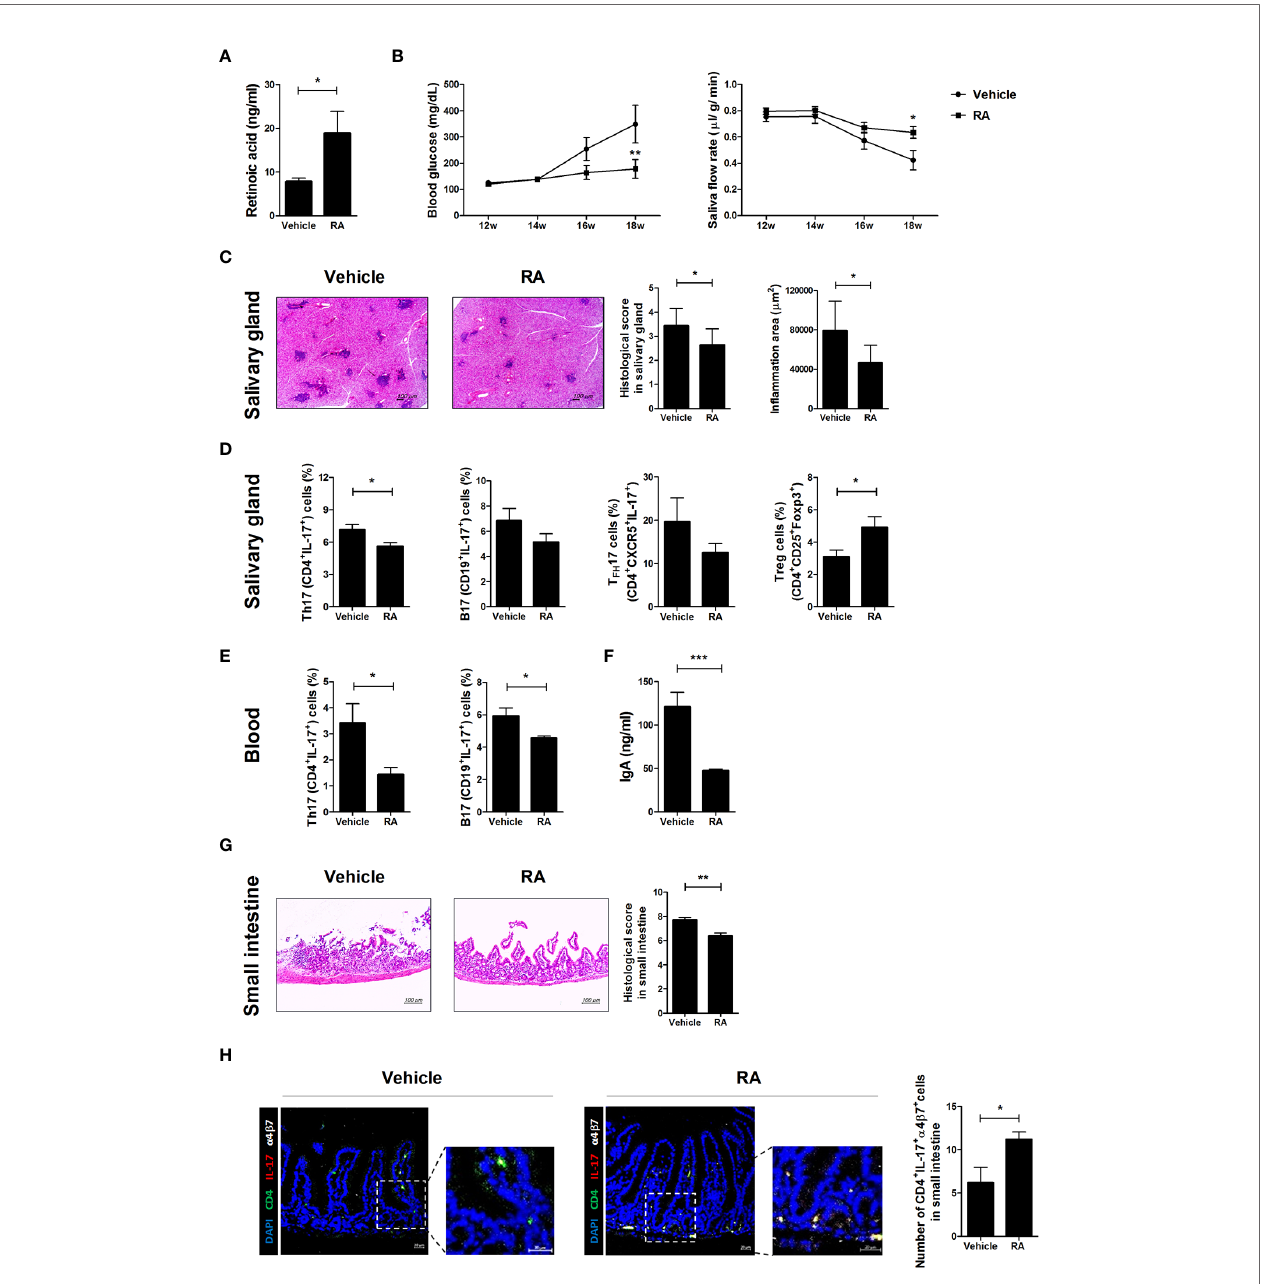
FIGURE 5 | Treatment with RA ameliorated SS symptoms in NOD/ShiLtJ mice. We injected 12-week-old NOD/ShiLtJ mice intraperitoneally with 1 mg/kg RA three times per week for 6 weeks. (A) Bar graph shows average RA levels in sera from vehicle- (N=5) and RA-treated mice (N=5). (B) Blood glucose levels (left) and salivary fl ow rates (right) were measured in vehicle- (N=10) and RA treated-NOD/ShiLtJ mice (N=10) at the indicated ages. (C) Representative H&E-stained images of salivary glands from vehicle- (left) (N=10) and RA treated- (right) NOD/ShiLtJ mice (N=10). Bar graph shows average in fl ammation area of salivary glands. Scale bar= 100 µm. (D) Bar graphs show average frequencies of Th17 (CD4 + IL-17 + ), B17 (CD19 + IL-17 + ), T FH 17 (CD4 + CXCR5 + IL-17 + ), and Treg (CD4 + CD25 + Foxp3 + ) cells among cells isolated from salivary glands of vehicle- (N=10) and RA-treated NOD/ShiLtJ mice (N=10). Cells were stimulated with PMA and ionomycin for 4 h and GolgiStop for the fi nal 2 h, and then stained with the indicated antibodies for fl ow cytometry analysis. (E) Bar graphs show average frequencies of Th17 (CD4 + IL-17 + ) and B17 (CD19 + IL-17 + ) cells in peripheral blood mononuclear cells of vehicle- (N=10) and RA-treated NOD/ShiLtJ mice (N=10). Cells were stimulated with PMA and ionomycin for 4 h and GolgiStop for the fi nal 2 h, and then stained with the indicated antibodies for fl ow cytometry analysis. (F) Bar graph shows average IgA levels in sera from vehicle- and RA-treated mice. (G) Representative H & E-stained images of small intestines from vehicle- (left) (N=10) and RA treated- (right) NOD/ShiLtJ mice (N=10). Bar graph shows average histological scores for small intestine tissues. Scale bar= 100 µm. (H) Representative immuno fl uorescence images for CD4 (green), IL-17 (red), a 4 b 7 (white) and DAPI counterstaining (blue) in small intestine tissues of vehicle- (N=5) and RA-treated mice (N=5). Original magni fi cation was 200×. Values are means ± SEM from three independent experiments. * p < 0.05, ** p < 0.01, *** p <